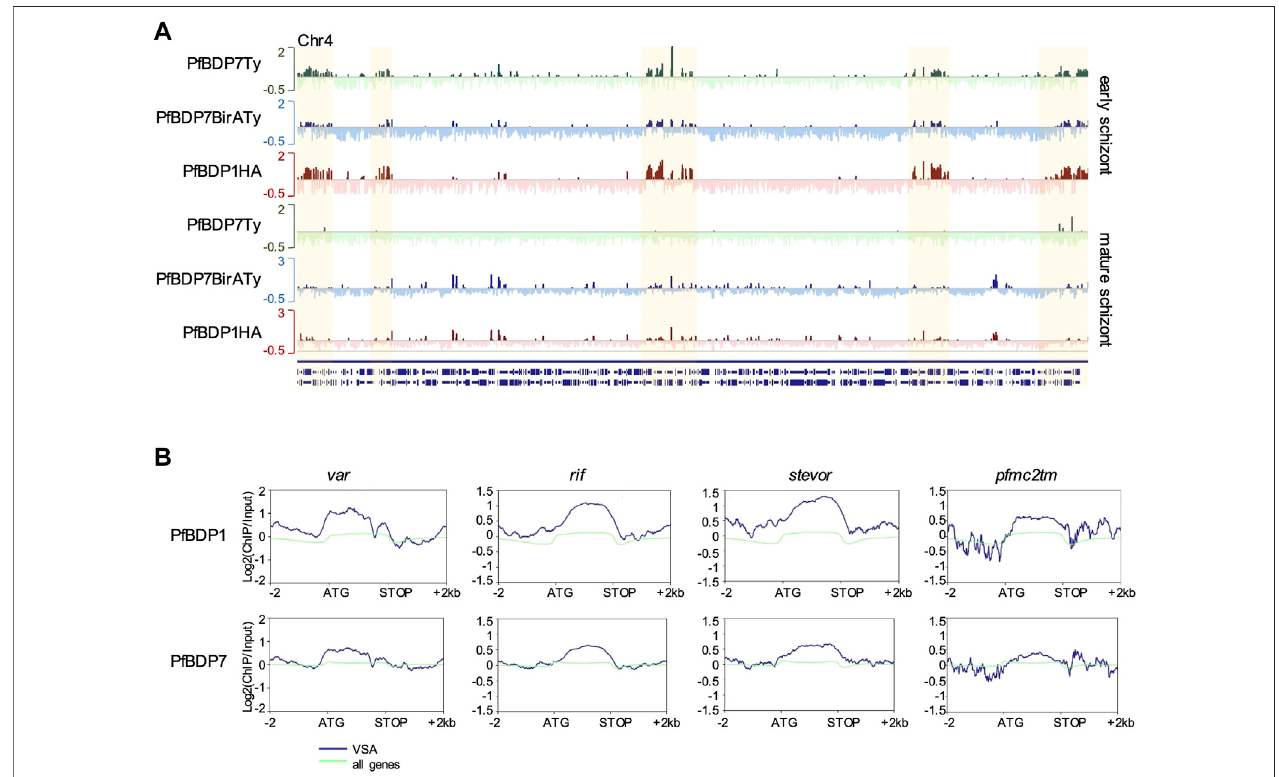
FIGURE7| PfBDP7andPfBDP1areenrichedacrossVSAgenebodiesinearlyschizonts. (A) Log2(ChIP/input)enrichmentpro fi lesofPfBDP7andPfBDP1inearly schizontsacrosschromosome4depictsaccumulationofChIPsignalsinheterochromaticregions(highlightedinyellow)containingVSAgenes.Green:PfBDP7Ty_Glms; blue: PfBDP7BirATy; red: PfBDP1HA. (B) Line plots of average PfBDP1 and PfBDP7 enrichment across VSA families var , rif , stevor and pfmc-2tm (blue) and all genes (green) in PfBDP1HA::PfBDP7BirATy early schizonts.